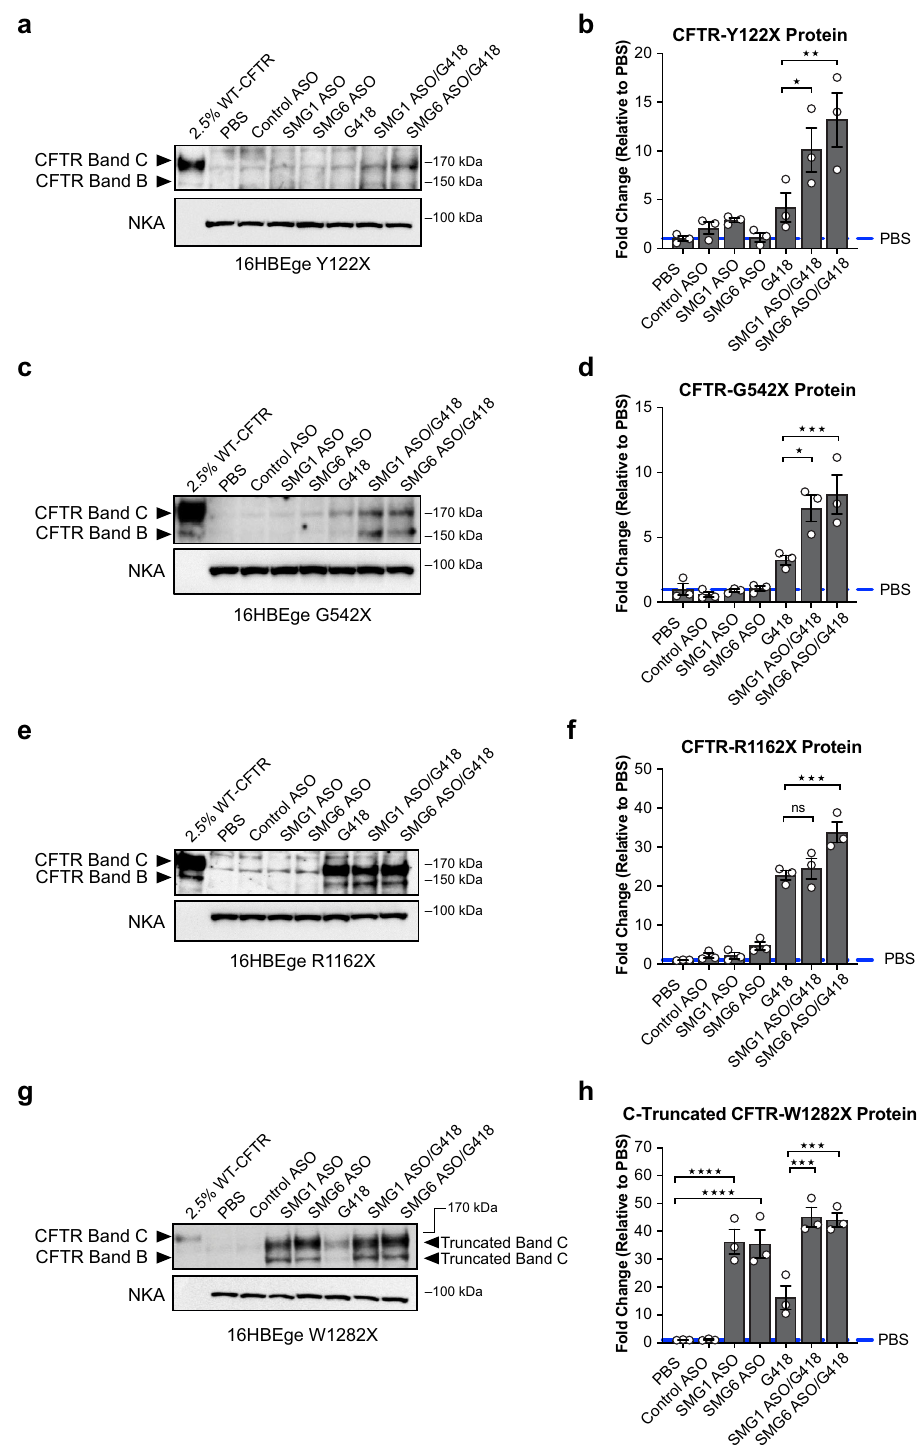
Fig. 6 SMG6- ASO treatment improves translational readthrough outcomes and enhances CFTR protein upregulation in CFF-16HBEge cells. Cells were treated with SMG1 - or SMG6 -ASO for 6 days followed by the addition of aminoglycoside geneticin (G418; 100 µ M) during the fi nal 2 days of ASO treatments. Representative western blot images (left) and quanti fi cation (right) of CFTR protein expression in CFF-16HBEge cells with ( a , b ) Y122X, ( c , d ) G542X, ( e , f ) R1162X, and ( g , h ) W1282X nonsense mutations following indicated treatment conditions. Full-length, complex-glycosylated band C of CFTR protein was evaluated for western blot quanti fi cation for ( b ) CFF-16HBEge-Y122X, ( d ) -G542X, ( f ) -R1162X cells. h C-truncated band C of CFTR-W1282X protein was quanti fi ed for CFF-16HBEge-W1282X cells. Na + /K + -ATPase (NKA) protein was used as a loading control. n = 3 for each group. Data are presented as mean ± SEM from biologically independent samples. Statistical signi fi cance was analyzed by one-way ANOVA followed by Sidak ’ s multiple- comparison test (* p < 0.05, ** p < 0.01, *** p < 0.001, **** p < 0.0001). See Source Data fi le for the exact p -values. Source data are provided as a Source Data fi